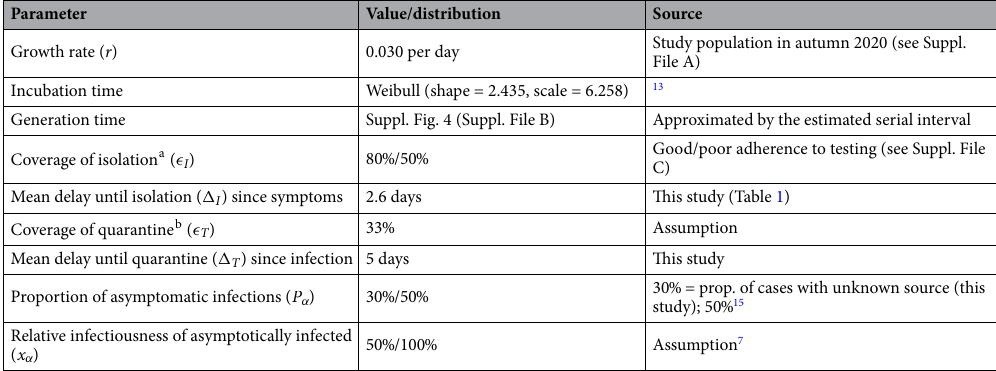
Table 3. Parameters and assumptions in the effectiveness model. The table summarises the parameters used to evaluate the counterfactual effective reproduction number in the absence of case isolation and contact tracing. a The parameter symbols refer to those as used in Supplementary File C. Proportion of symptomatic SARS- b CoV-2 cases that are tested and isolated. Proportion of secondary cases set to quarantine before symptom onset due to contact